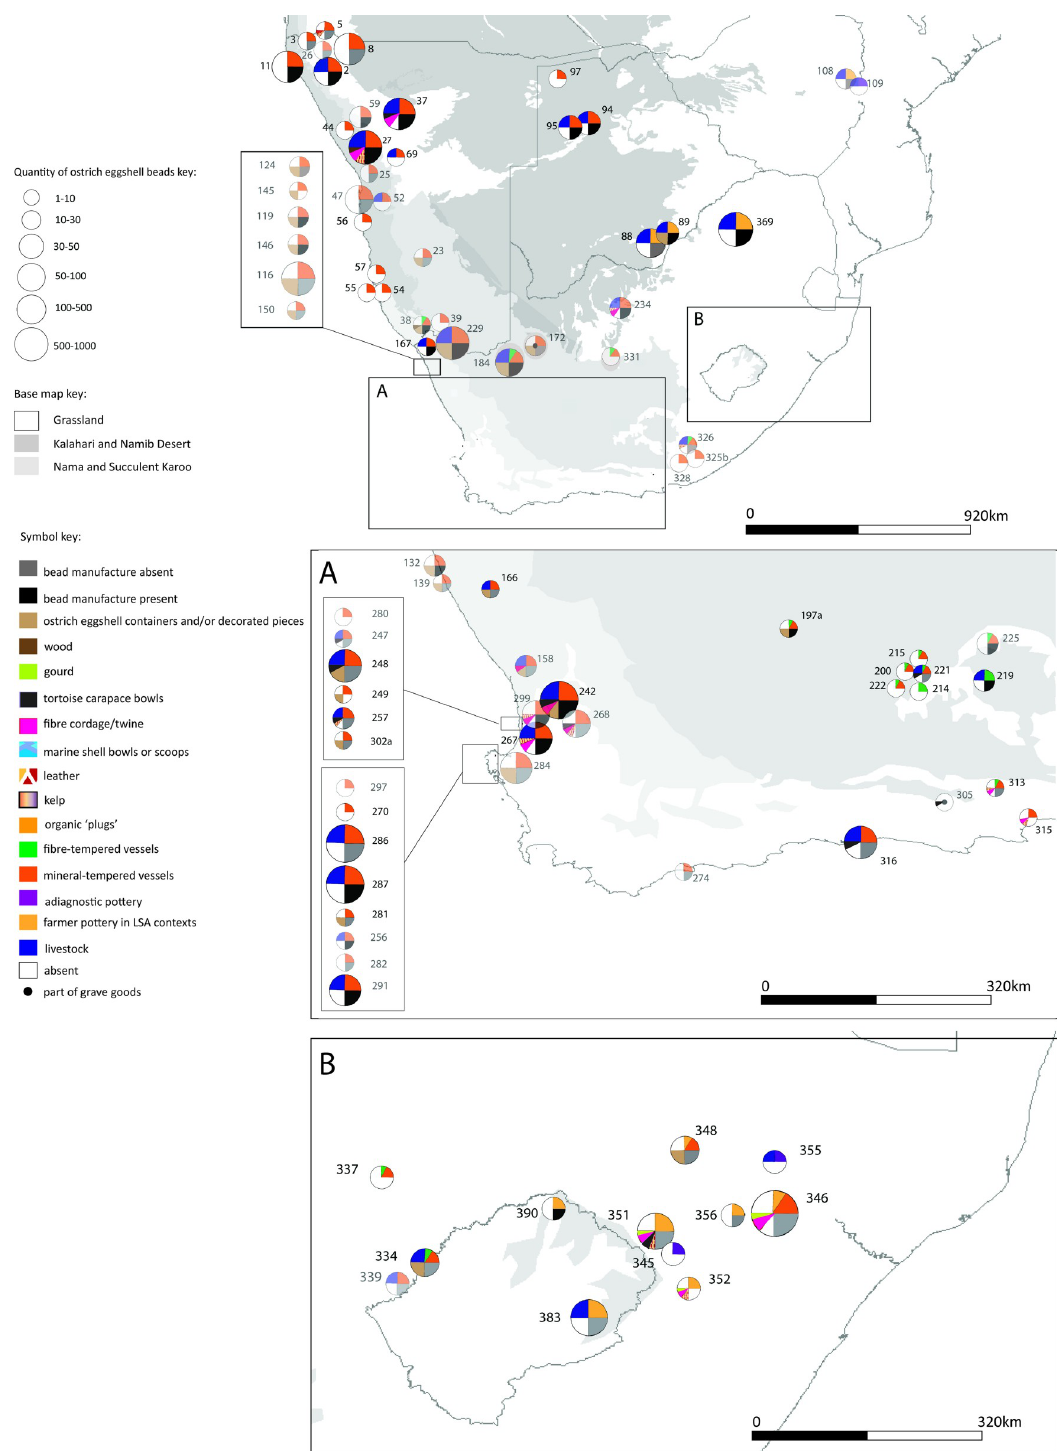
Fig 8. Map 4 showing the distribution of organic finds, livestock and pottery in the period cal AD 912–1512.